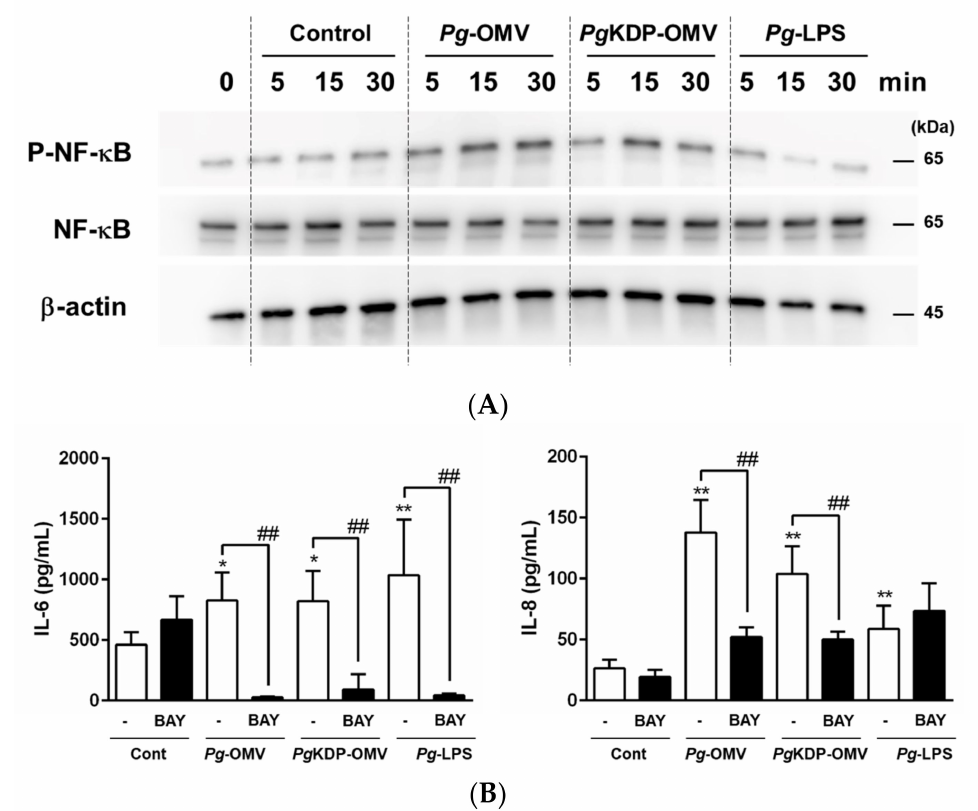
Figure 4. Involvement of NF- κ B in the induction of IL-6 and IL-8 production by Pg -OMVs, Pg KDP-OMVs, or Pg -LPS in OBA-9 cells. ( A ) OBA-9 cells were cultured with Pg -OMVs, Pg KDP-OMVs, or 100 ng/mL of Pg -LPS for 5, 15, and 30 min each. The amount of OMVs added to cells was determined by using the same level of endotoxin activity as 100 ng/mL of Pg -LPS. Phos- phorylated NF- κ B was assessed by Western blotting; representative blots are shown. ( B ) OBA-9 cells were pre-treated with BAY11-7082 (10 µ M) for 1 h before the addition of Pg -OMVs, Pg KDP-OMVs, or 100 ng/mL of Pg -LPS, for 6 h. IL-6 and IL-8 concentrations in the cell culture supernatants were determined using an ELISA program. Data are the mean ± SD of three independent experiments. * p < 0.05 and ** p < 0.01, compared to the unstimulated control. ## p < 0.01 compared to the control without